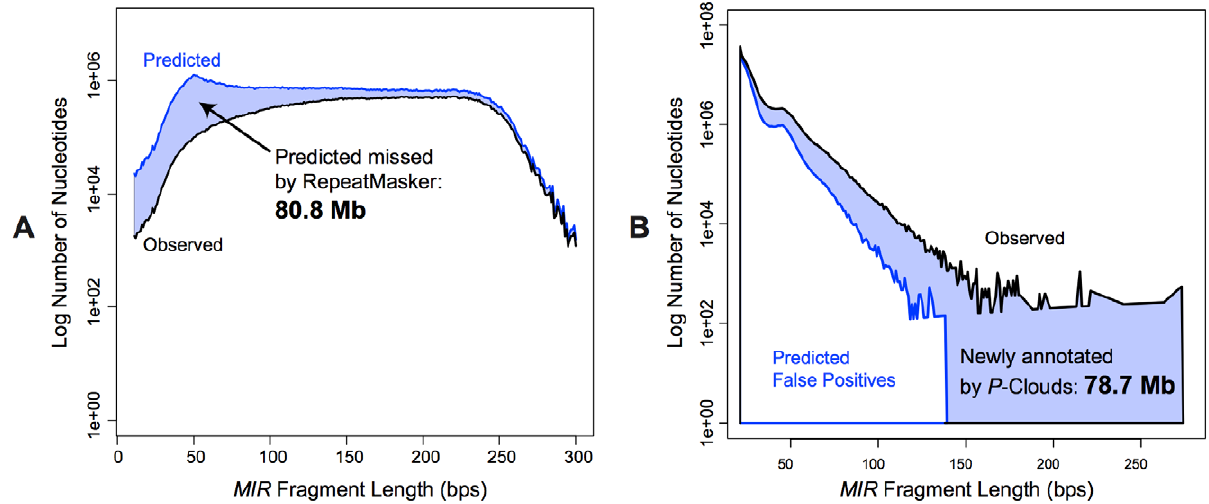
Figure 6. MIR element-specific P-clouds detect the short fragments that RepeatMasker cannot. A) Predicted true distribution of MIR fragments in the human genome, using observed RepeatMasker results and RepeatMasker’s sensitivity estimates from Figure 5B. B) Novel P -clouds annotations on the RepeatMasked portion of the human genome, minus predicted false positives from dinucleotide simulations (see text).